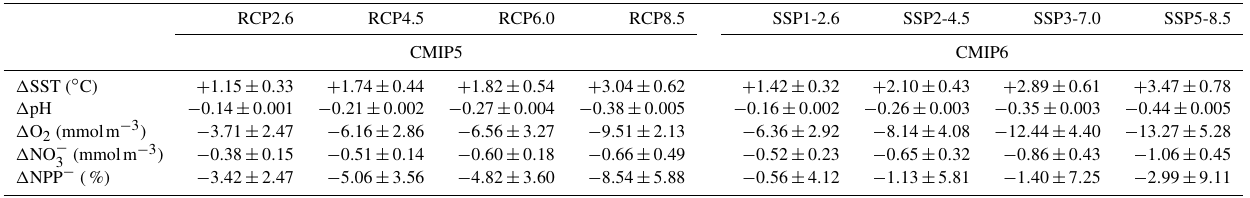
Table 4. Global mean changes in multiple ocean impact drivers across the CMIP6 and CMIP5 ensembles. Global mean anomalies of sea surface temperature, surface ocean pH, subsurface dissolved O 2 concentration (averaged between 100 and 600m), upper-ocean NO − (averaged between 0–100m), and depth-integrated net primary production for the CMIP6 SSPs and CMIP5 RCPs. Anomalies are given as 2080–2099 mean values relative to the 1870–1899 mean. Uncertainty estimates are the inter-model standard